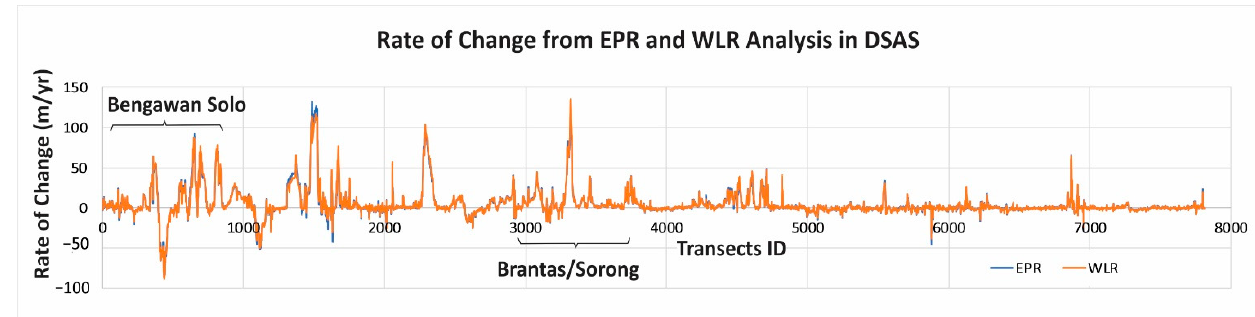
Figure 5. End point rate (EPR) and weighted linear regression rate (WLR) statistics from the transect lines, revealing major regions of shoreline changes along the shoreline of East Java.